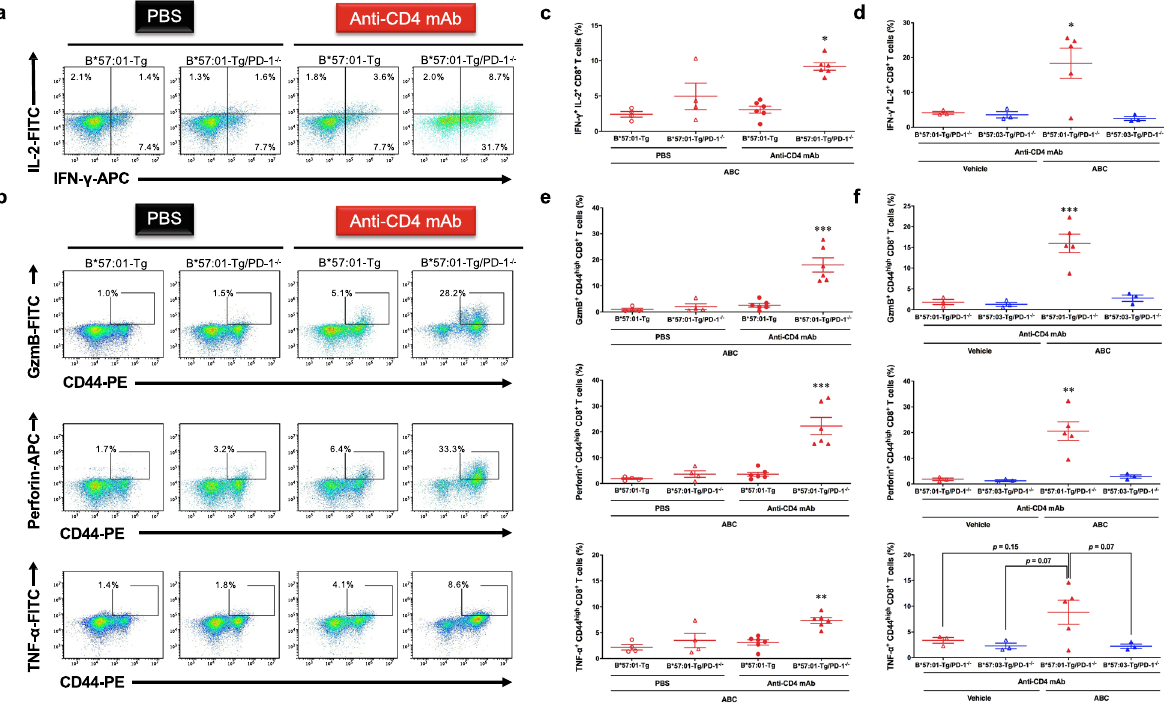
Fig. 5 Abacavir (ABC)-induced immunotoxicity in CD4 + T cell-depleted B*57:01-Tg/PD-1 − / − transgenic (Tg) mice. a and b Representative dot plots depicting ( a ) cytokine and ( b ) cytolytic granule production in CD8 + T cells in the lymph nodes (LNs) derived from CD4 + T cell-depleted/PBS-treated B*57:01-Tg mice or B*57:01-Tg/PD-1 − / − mice. Each group was orally administrated 1% (w/w) abacavir (ABC) for 1 week. Data are representative of four independent experiments. c – f Percentage of ( c and d ) cytokines and ( e and f ) cytolytic granule production in CD8 + T cells isolated from the LNs. Each plot represents an individual mouse with the mean ± SEM ( N = 3 – 6); * p < 0.05, ** p < 0.01, *** p < 0.001 by one-way ANOVA with Bonferroni ’ s multiple comparisons correction, compared with other control groups; indicated p value was obtained from a statistical comparison. Data are a summary of 4 ( c , e ) or 3 ( d , f ) independent